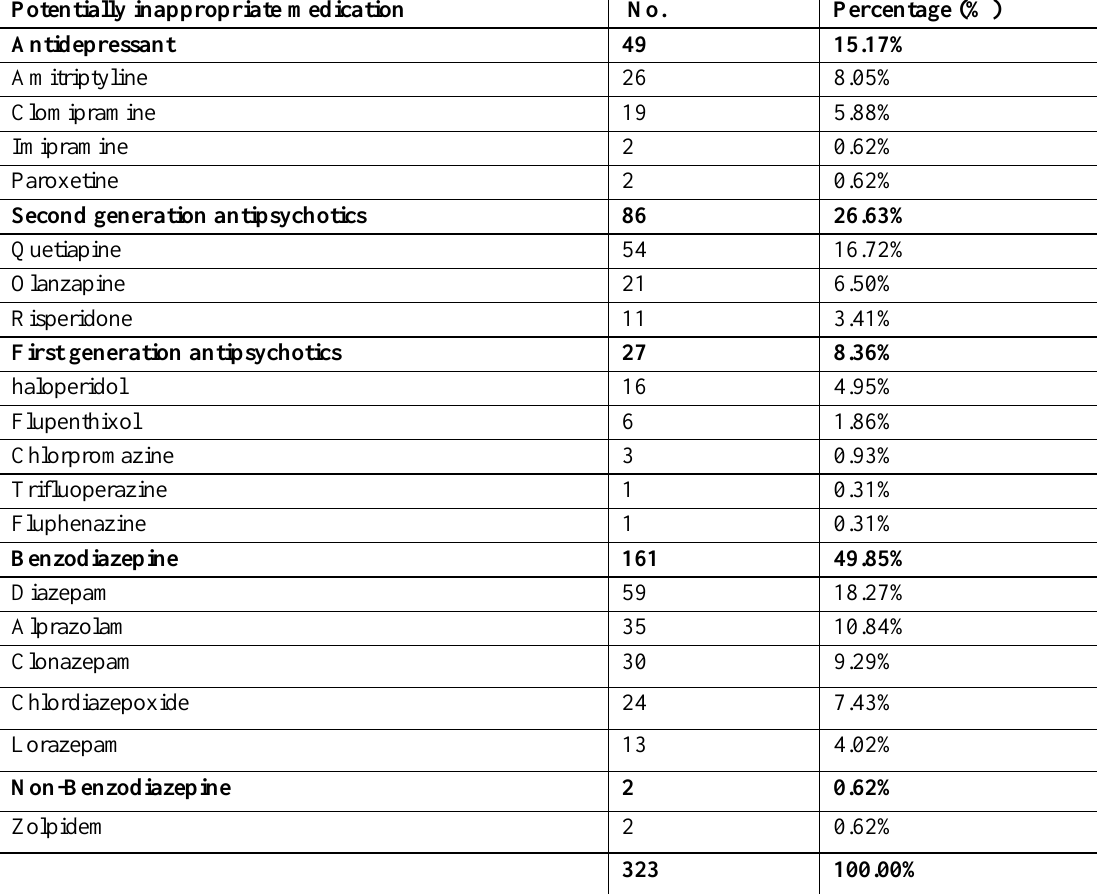
Table 3 . Potentially inappropriate medication regardless of patient